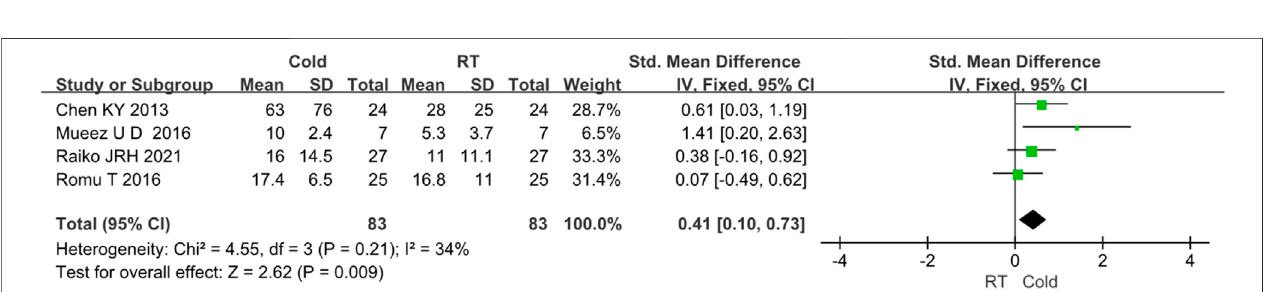
FIGURE 4 | Forest plot for the effect of cold temperature on human brown adipose tissue volume.